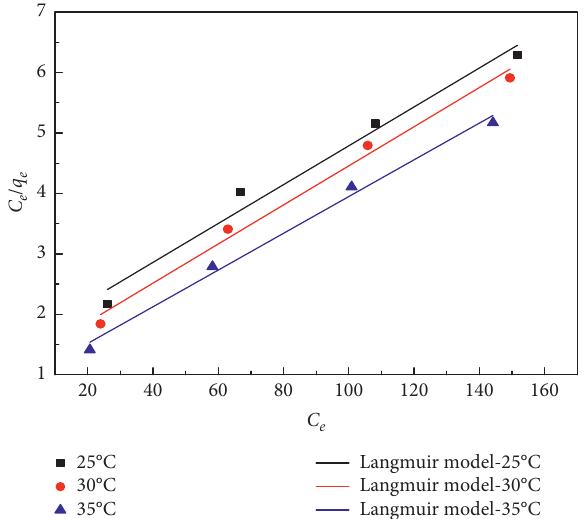
Figure 10: Langmuir isotherm plots for the uptake of ammonium on the